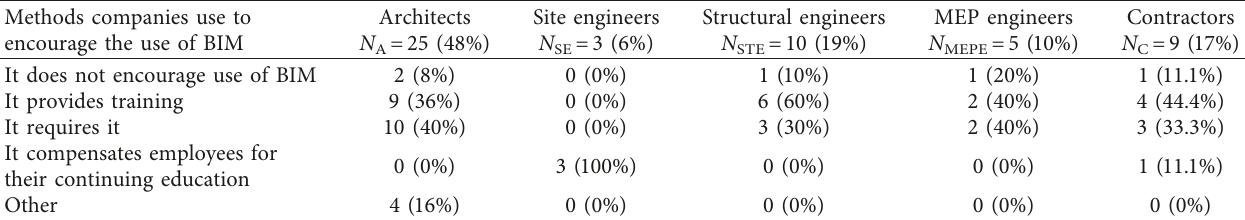
Table 3: Relationship between the role of the respondent and their company’s method for encouraging BIM use. Methods companies use to